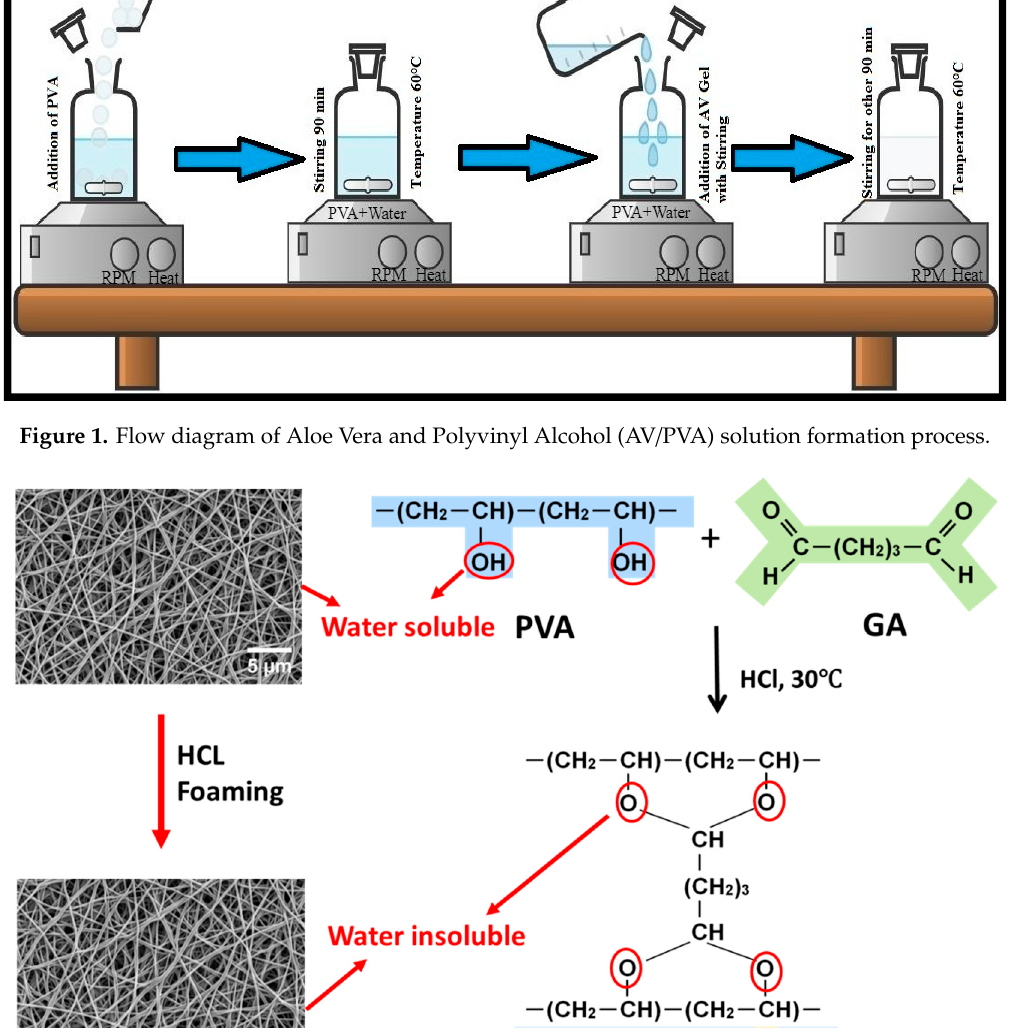
Figure 1. Flow diagram of Aloe vera and polyvinyl alcohol (AV/PVA) solution formation process.